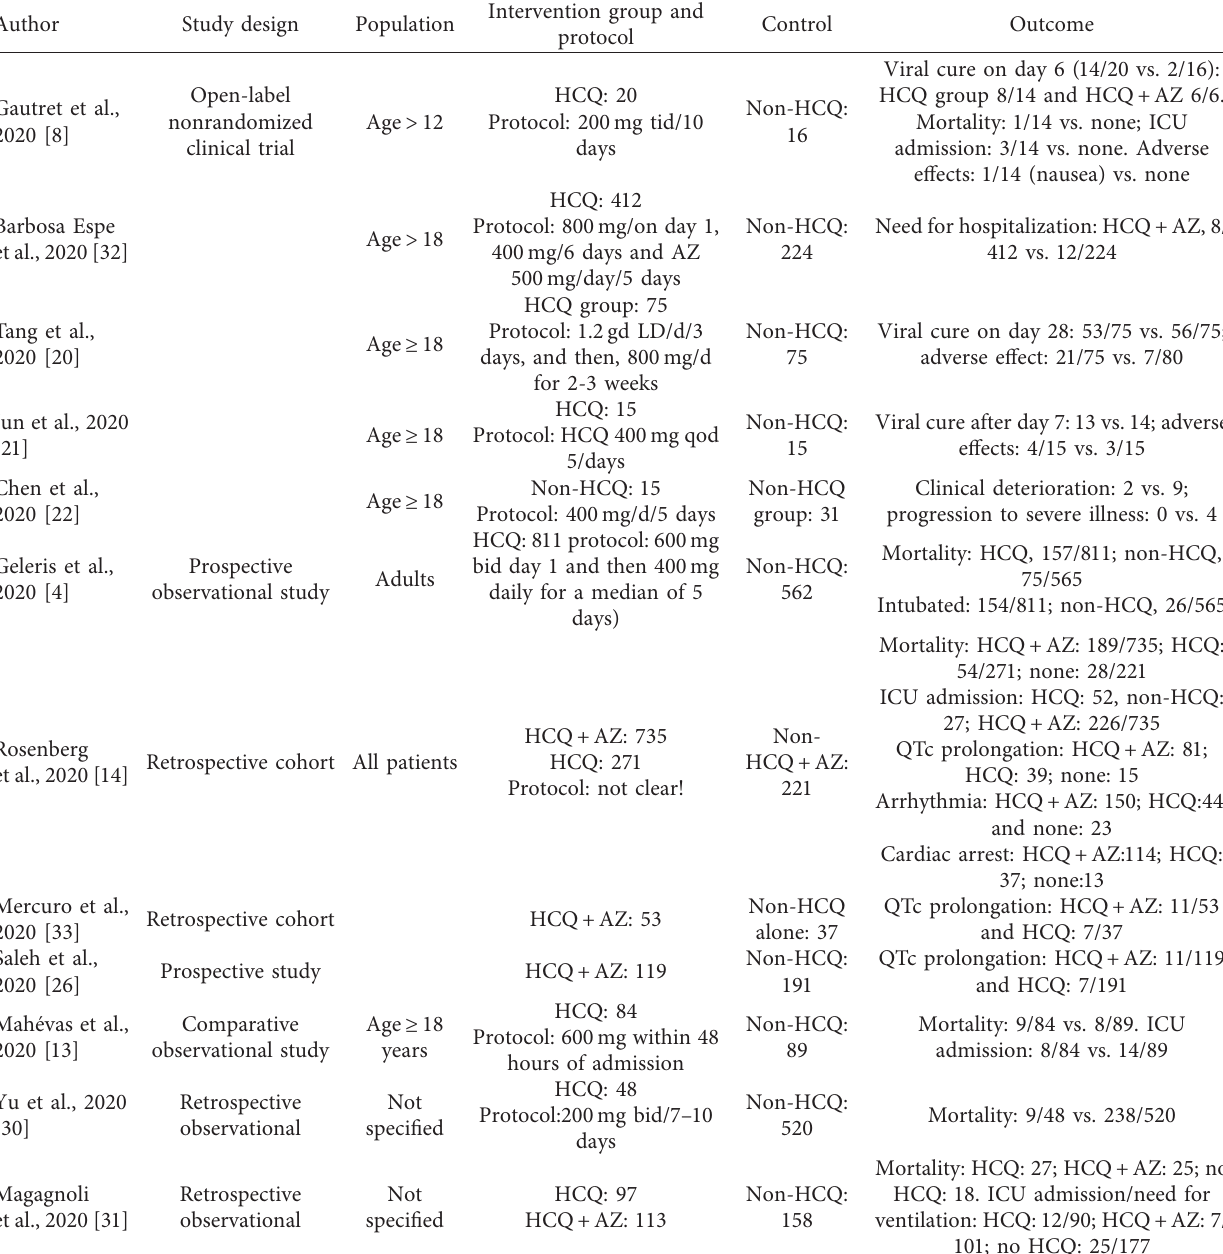
Table 1: Characteristics of the studies included in the